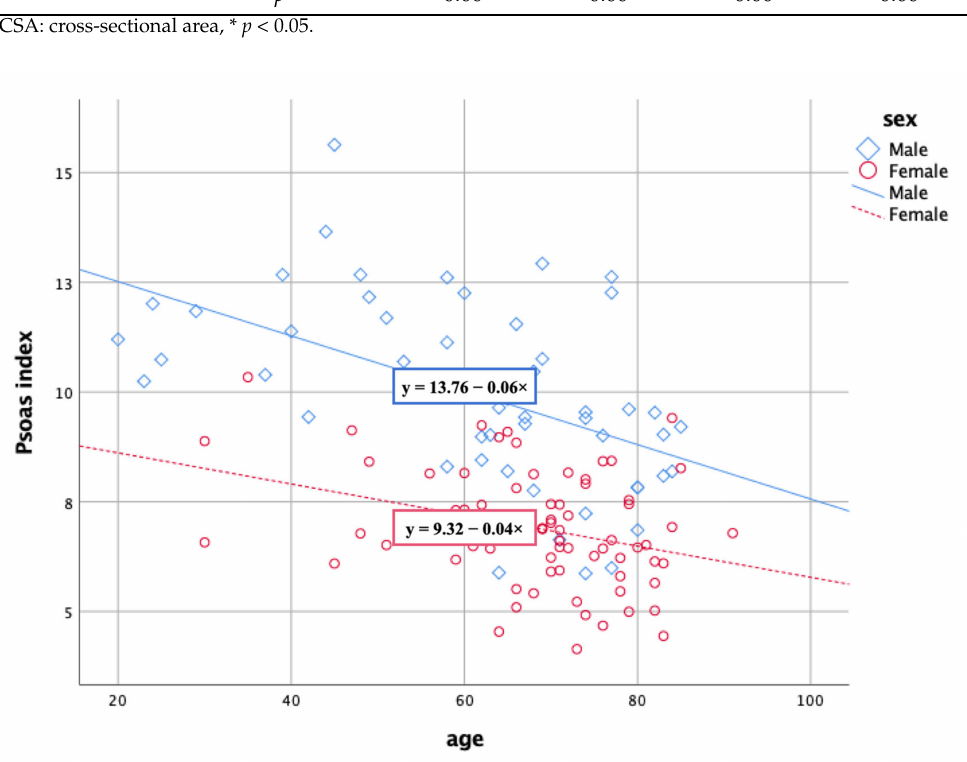
Figure 4. Psoas index and age showing a negative correlation. Age and sex affected psoas